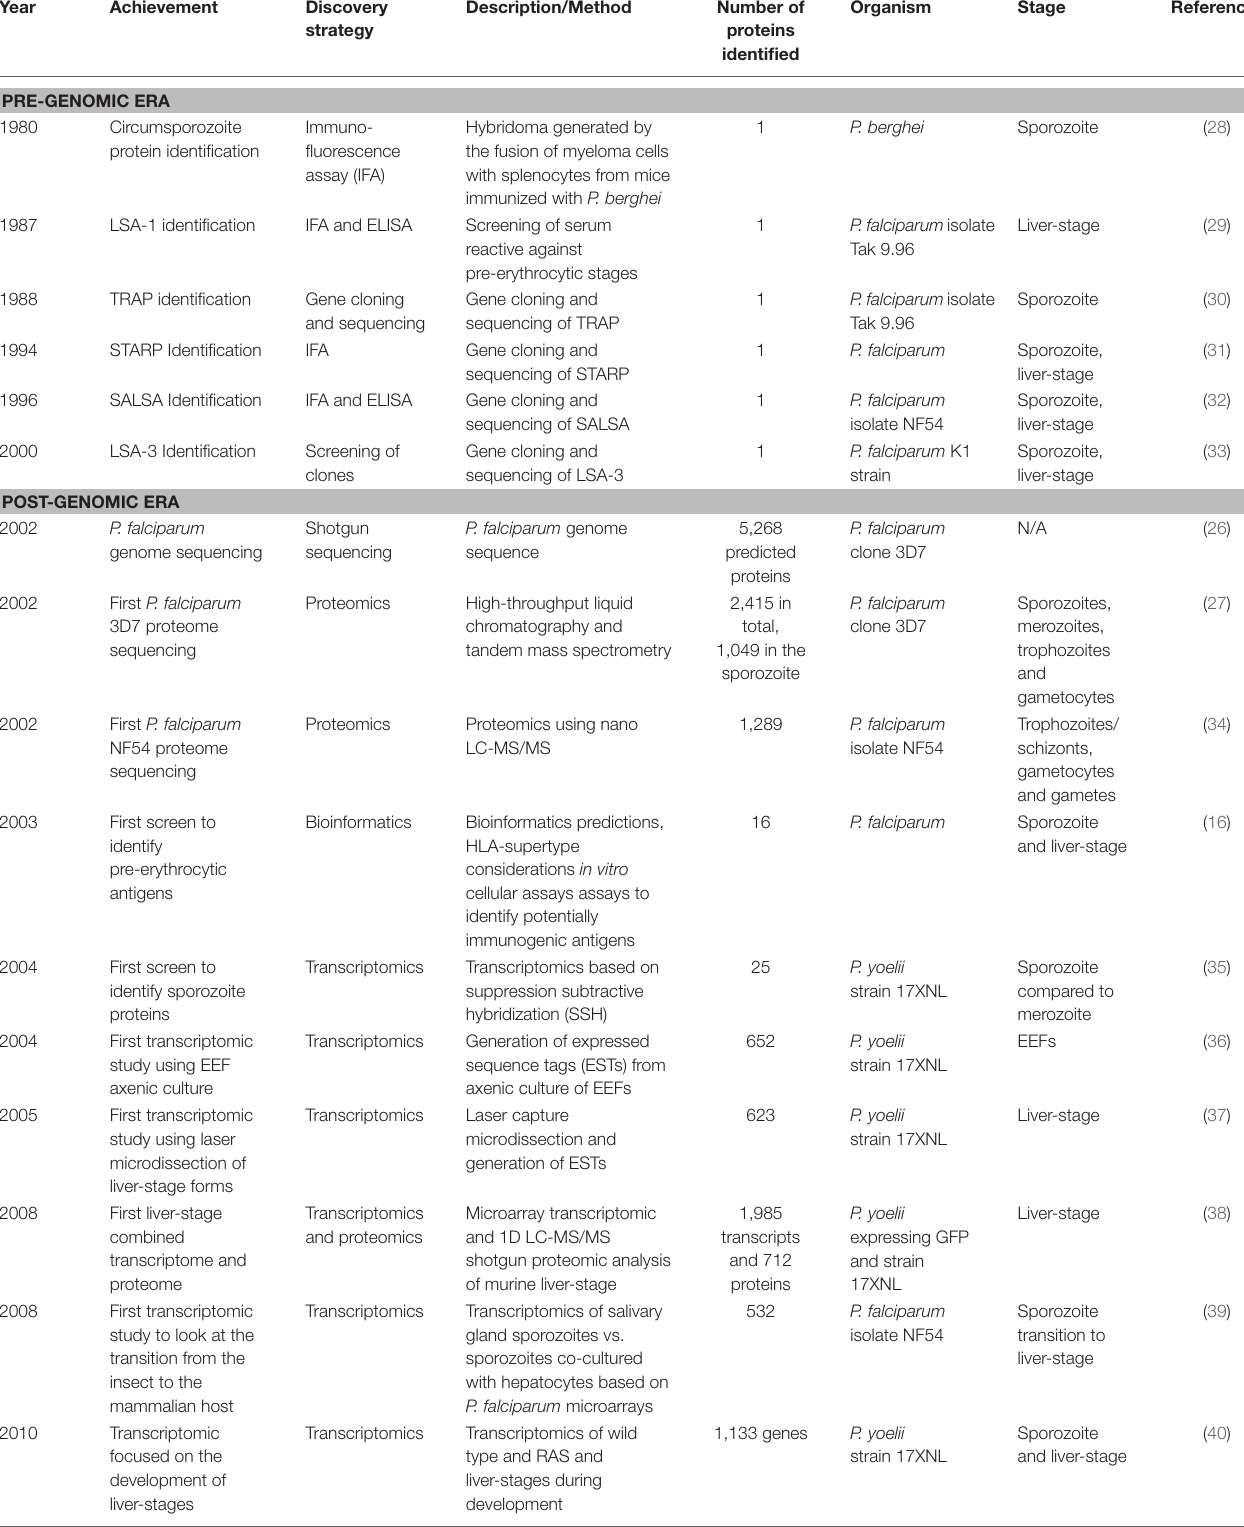
TABLE 1 | Major achievements leading to the identification of pre-erythrocytic proteins in chronological